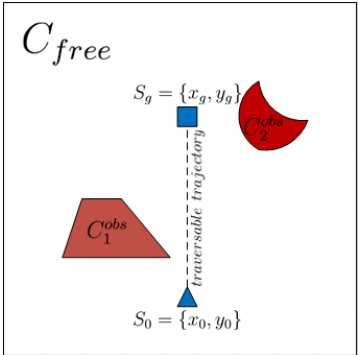
Figure 1. Landmarks within the map before being discretized.